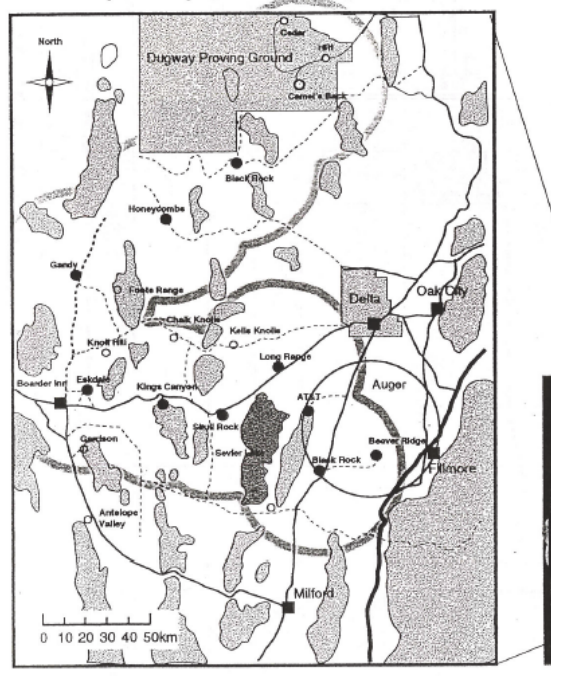
Figure 9. Proposed Snake Array cites in NW